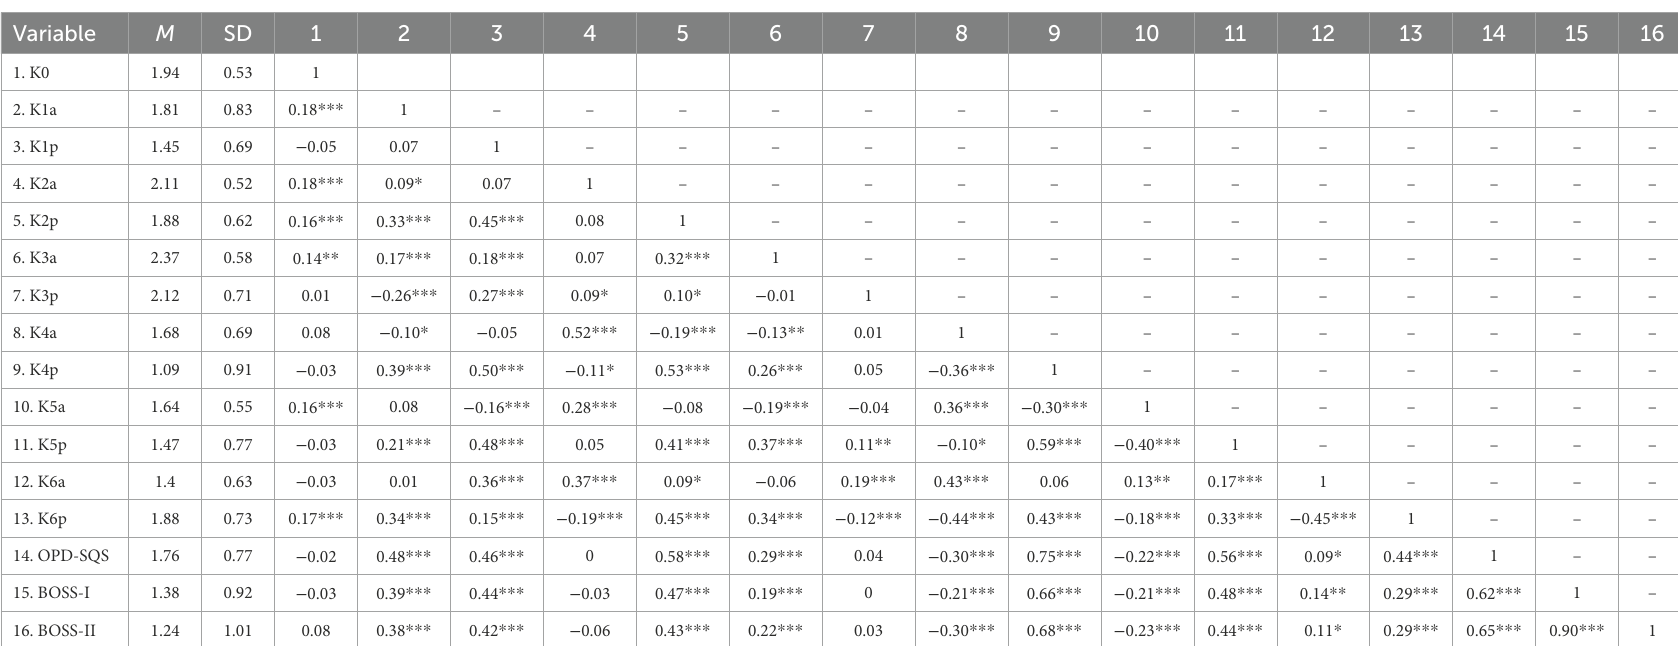
TABLE 4 Descriptive statistics and intercorrelations ( N =